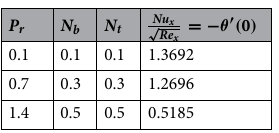
Nu x θ ′ ( 0 ) for various values of P r , N b and N t when M = G r = N r = R b = 0.5, √ Re x = −